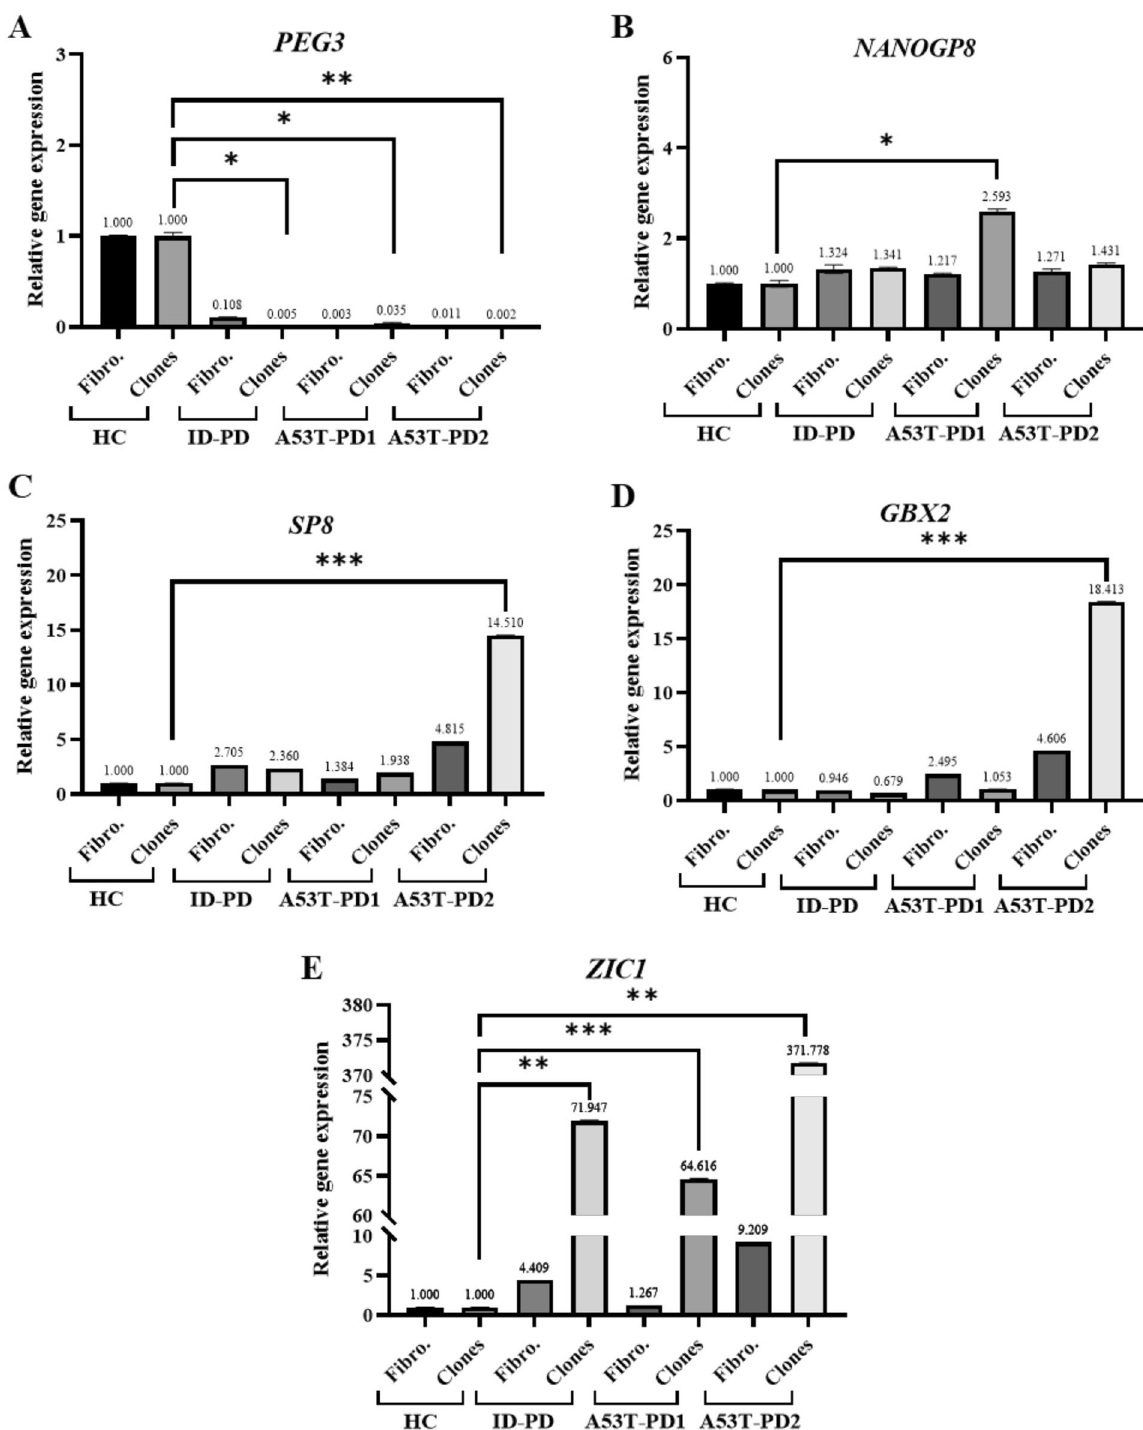
Figure 7. RT-qPCR analysis for the five selected genes supported the possible role of those genes in iPSC reprogramming. ( A – E ) Representative graphs for RT-qPCR analysis of the five nominated genes ( PEG3, NANOGP8, SP8, GBX2 and ZIC1 ) that were expressed by both fibroblasts and generated iPS cell lines. Relative gene expression was normalized to GAPDH expression. Fibro: fibroblasts. Statistical significance was tested using the Mann–Whitney U test; ns: non-significant; * P < 0.05; ** P < 0.01; *** P < 0.001. Results represent triplicates with similar